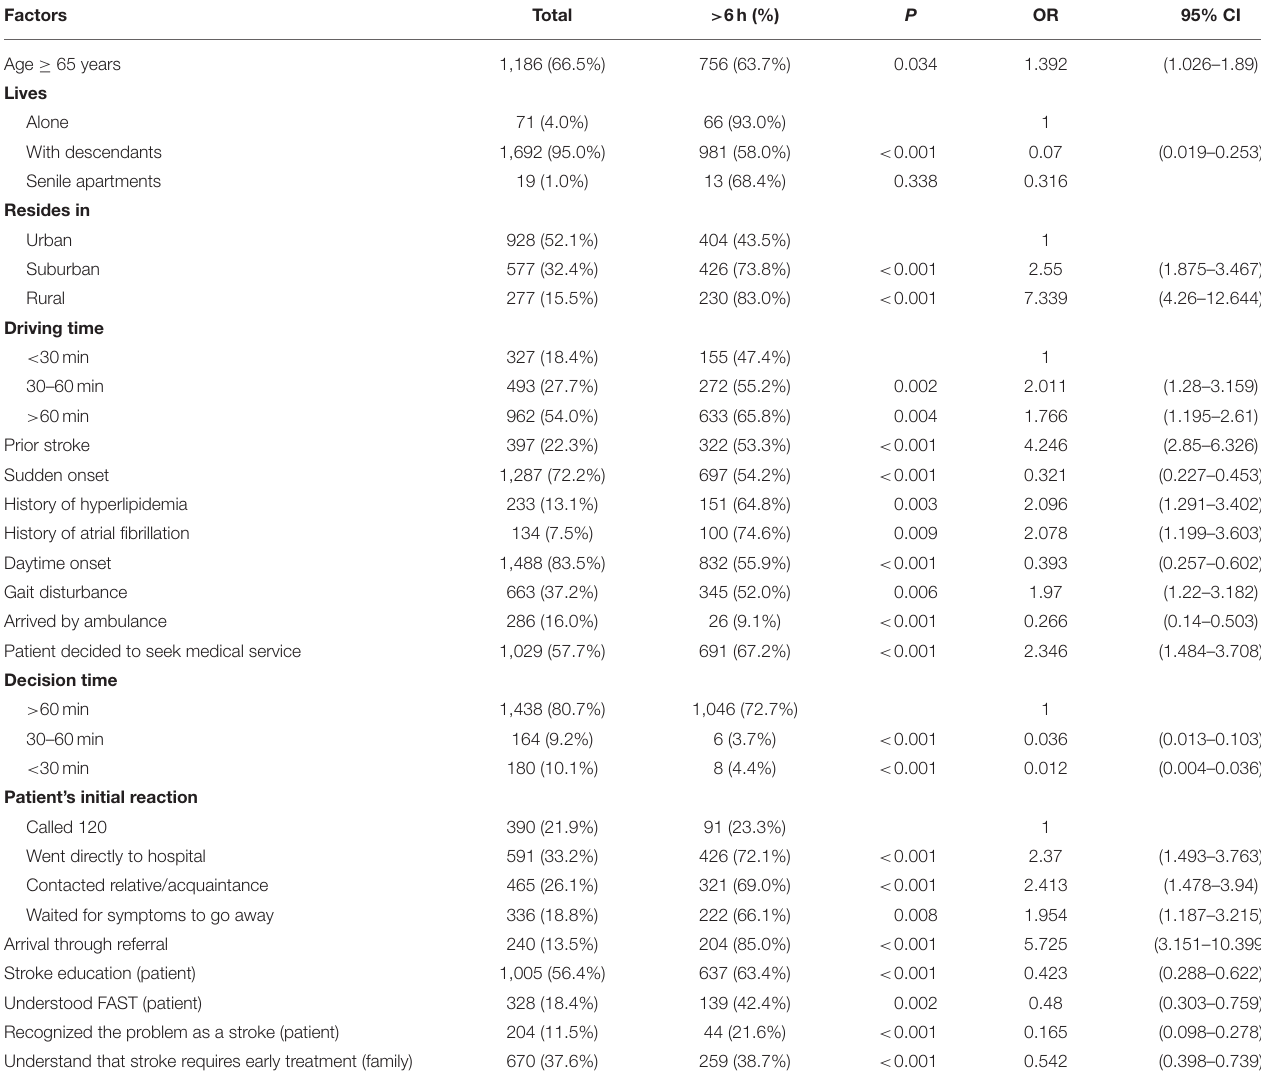
TABLE 2 | Logistic regression model of potential determinants for delay